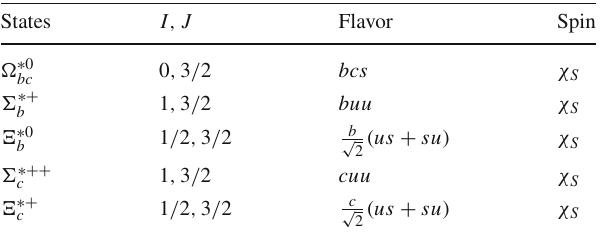
Table 2 Wave functions for baryons with J P = 3 / 2 + and I = 0 , 1 / 2 , 1. S in χ S stands for full symmetric States Flavor Spin